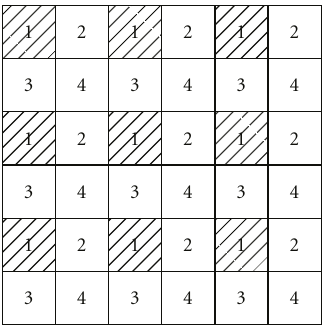
Figure 7: A TDMA scheduling scheme in local communications with CRF = 4.